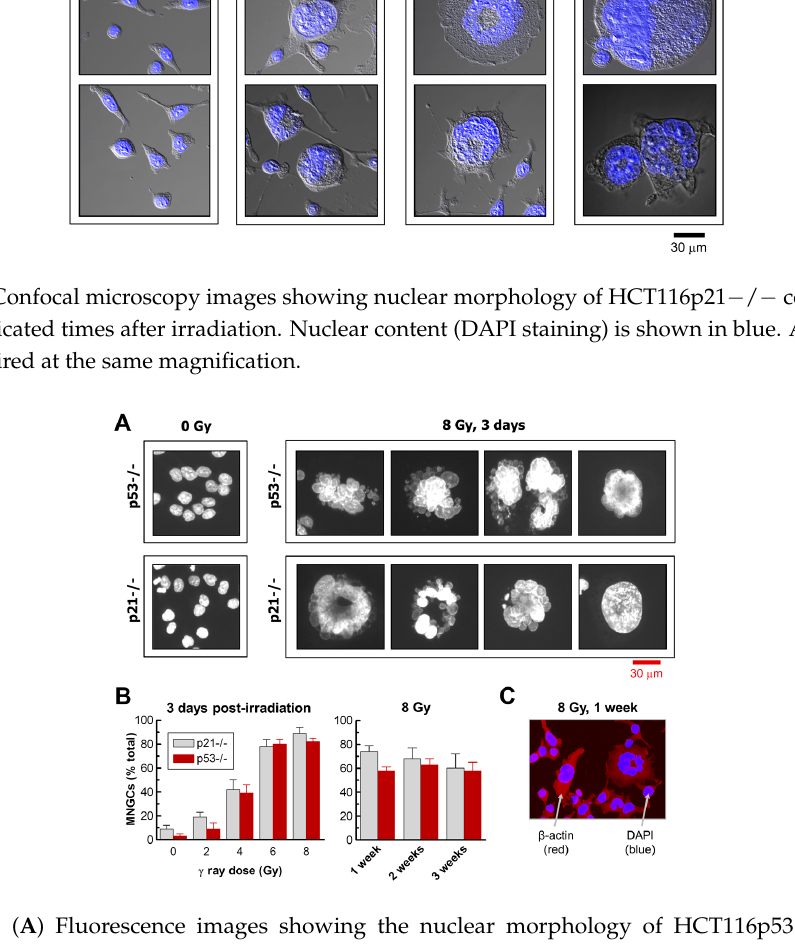
Figure 2. ( A ) Fluorescence images showing the nuclear morphology of HCT116p53 − / − and HCT116p21 − / − cells before and after irradiation. Nuclear content (DAPI) is shown in white. All images were acquired at the same magnification; ( B ) Proportion of MNGCs arising in cultures of the indicated cell lines following radiation exposure; Bars, SE (Standard error). At ~1 week post-